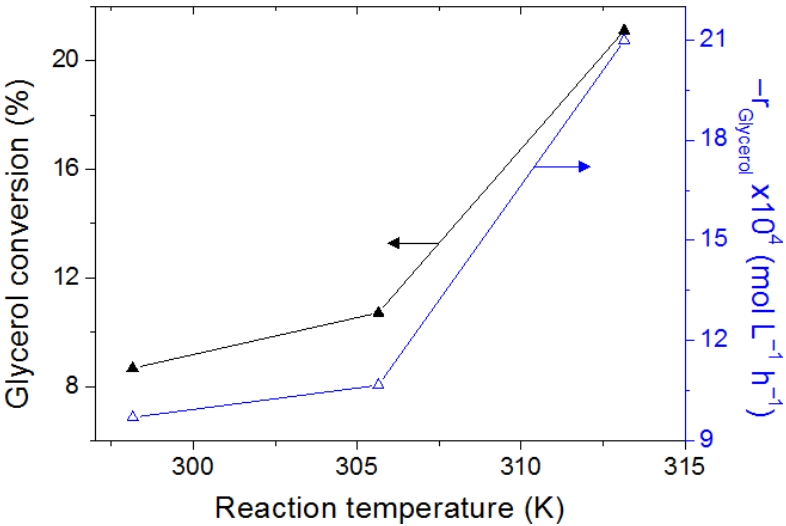
Figure 10. Effect of reaction temperature on the glycerol conversion and initial reaction rate (initial glycerol = 6.25 × 10 −2 M, Cu/TiO 2 = 0.25 g/L).